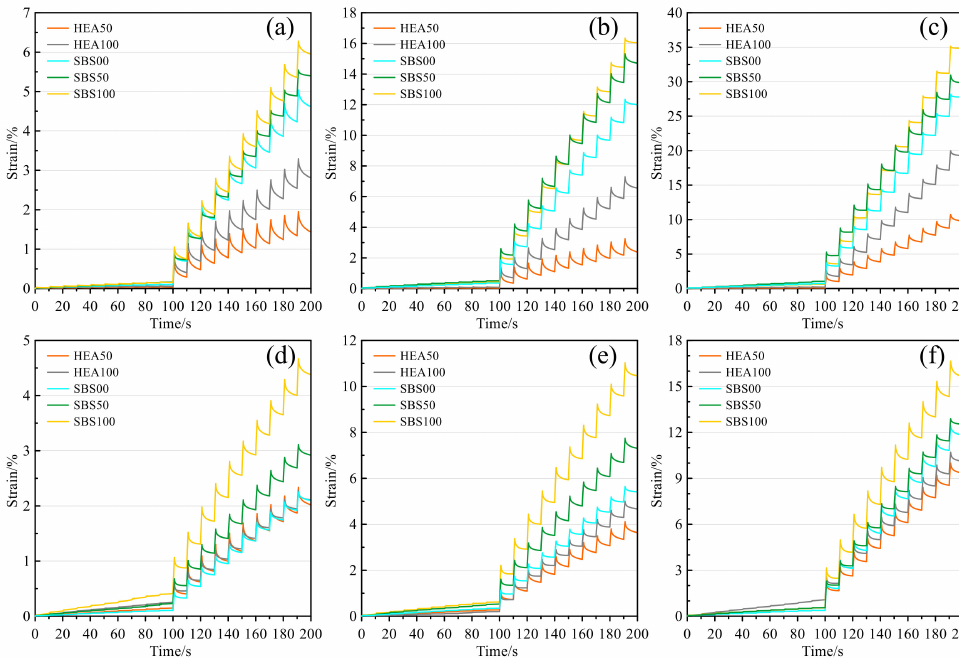
Figure 9. Strain curve: ( a ) 58 ◦ C before TFOT; ( b ) 64 ◦ C before TFOT; ( c ) 70 ◦ C before TFOT; ( d ) 58 ◦ C after TFOT; ( e ) 64 ◦ C after TFOT; ( f ) 70 ◦ C after